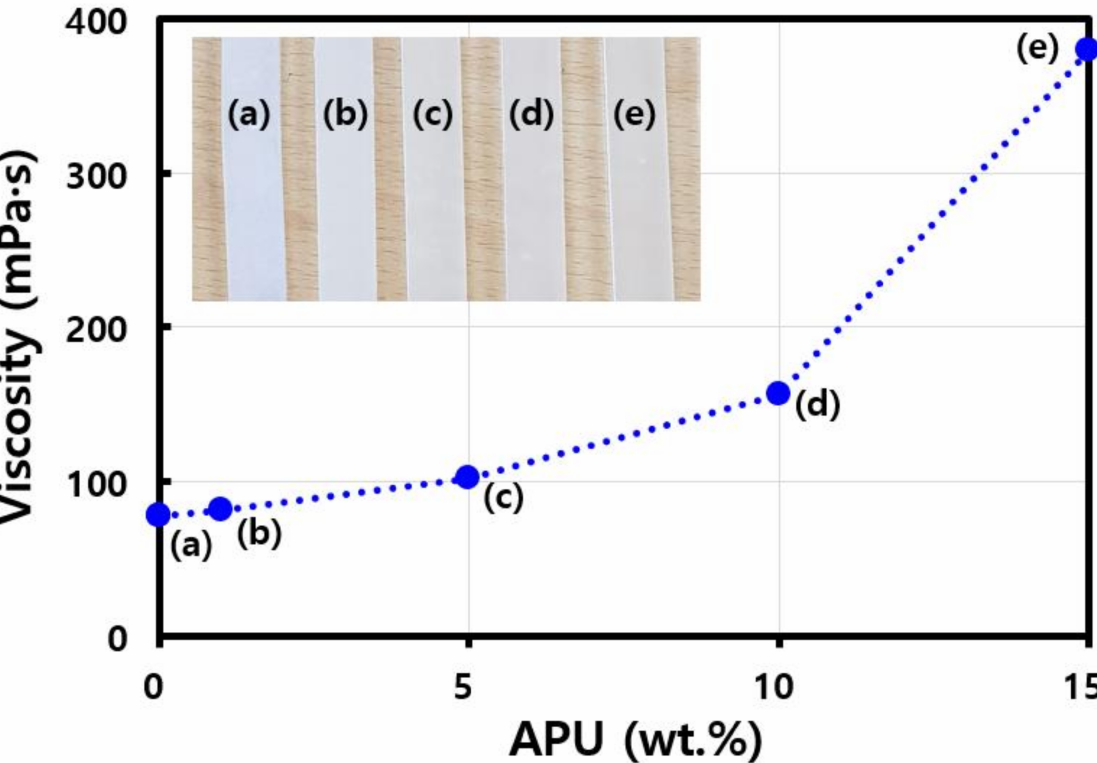
Figure 2. Viscosity behavior as a function of APU contents for uncured PA-APU resin: Rectangular 3D objects printed by various APU contents in base resin (HDDA): ( a ) APU 0 wt.%, ( b ) APU 1 wt.%, ( c ) APU 5 wt.%, ( d ) APU 10 wt.%, ( e ) APU 15